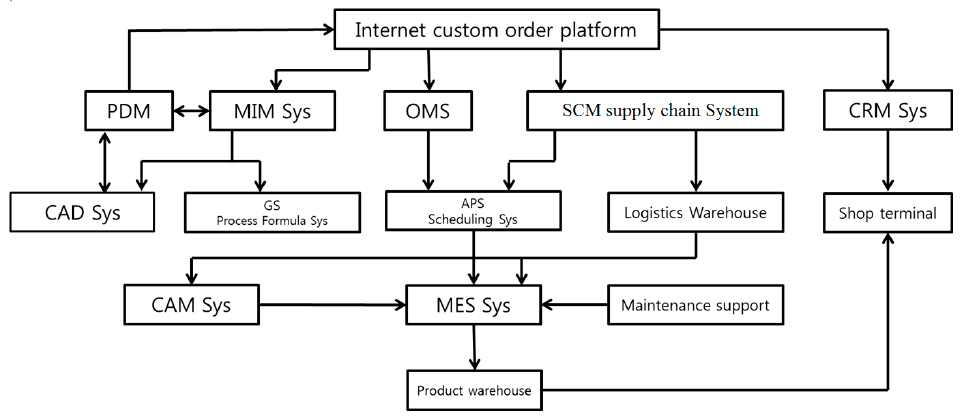
Figure 1. A flexible supply chain and digital system.